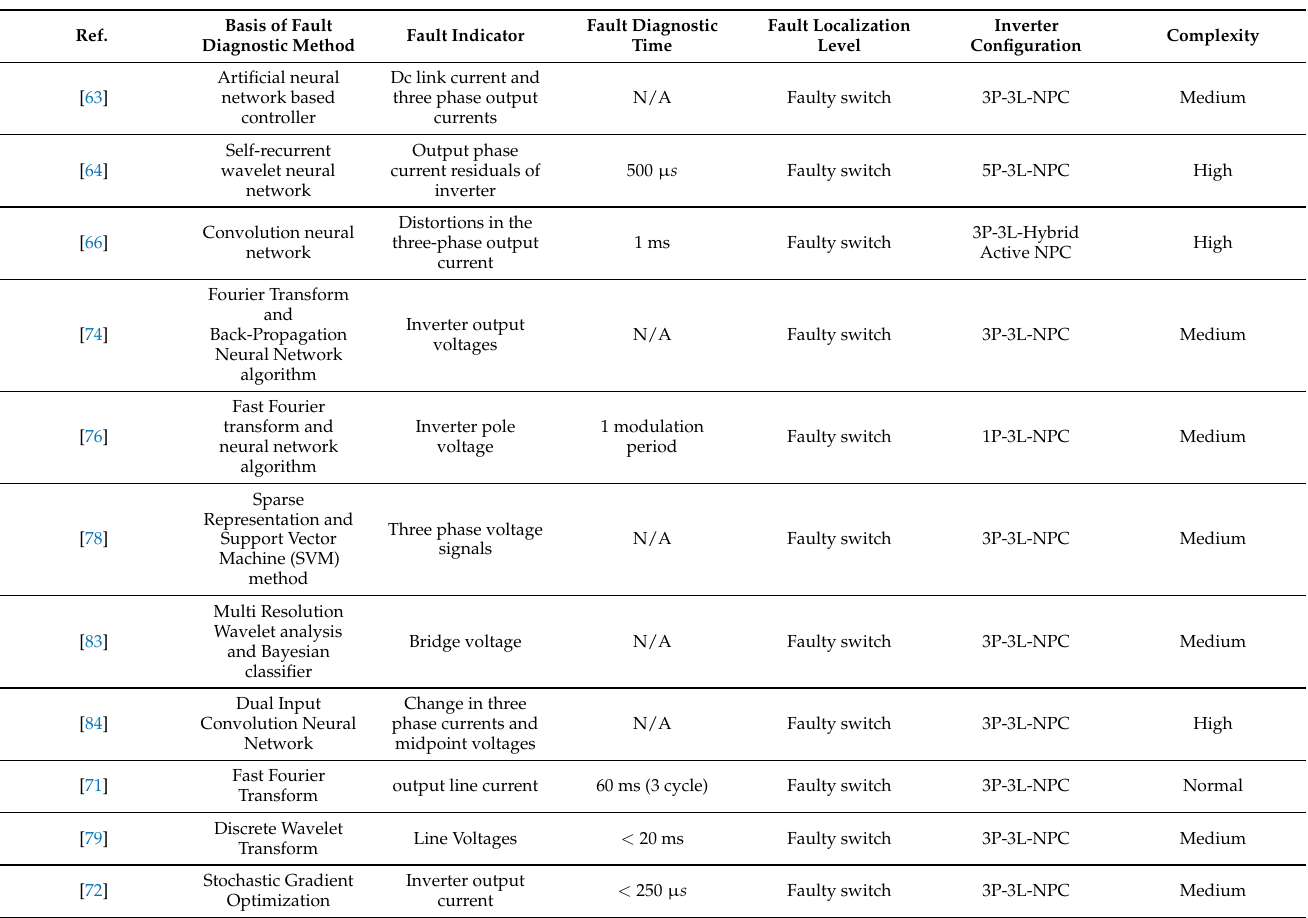
Table 5. Data based fault diagnostic